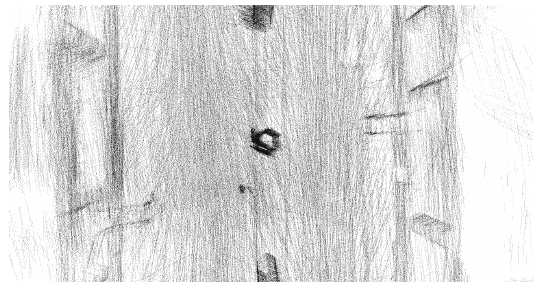
Figure 8. Map generated by the SLAM approach for the metro station dataset using an inappropriate timestamp offset of 19 ms. Blurry edges indicate a small clarity for this point